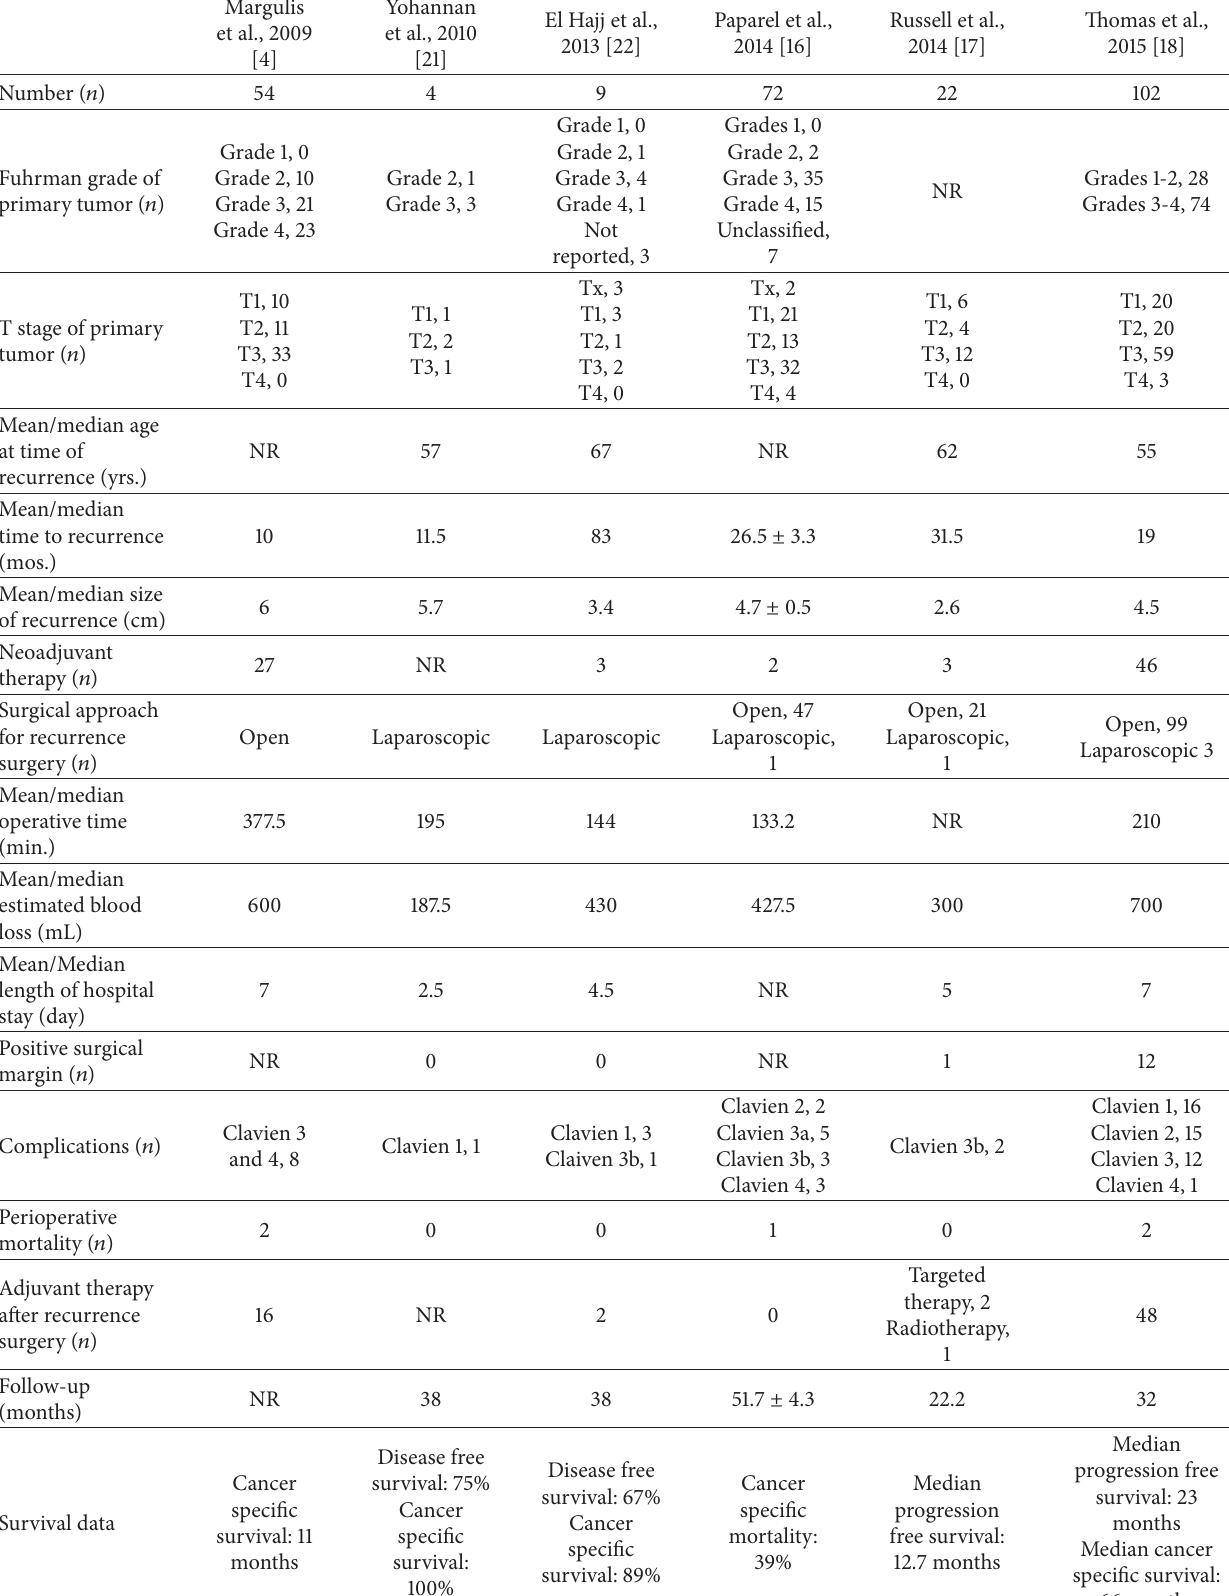
Table 1: Outcomes selected contemporary series of surgical experience in the treatment of localized recurrence of RCC (NR: not